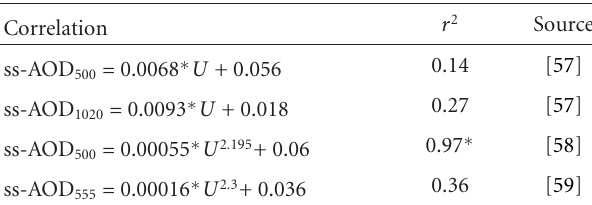
Table 1: Regression statistics for ss-AOD versus surface wind